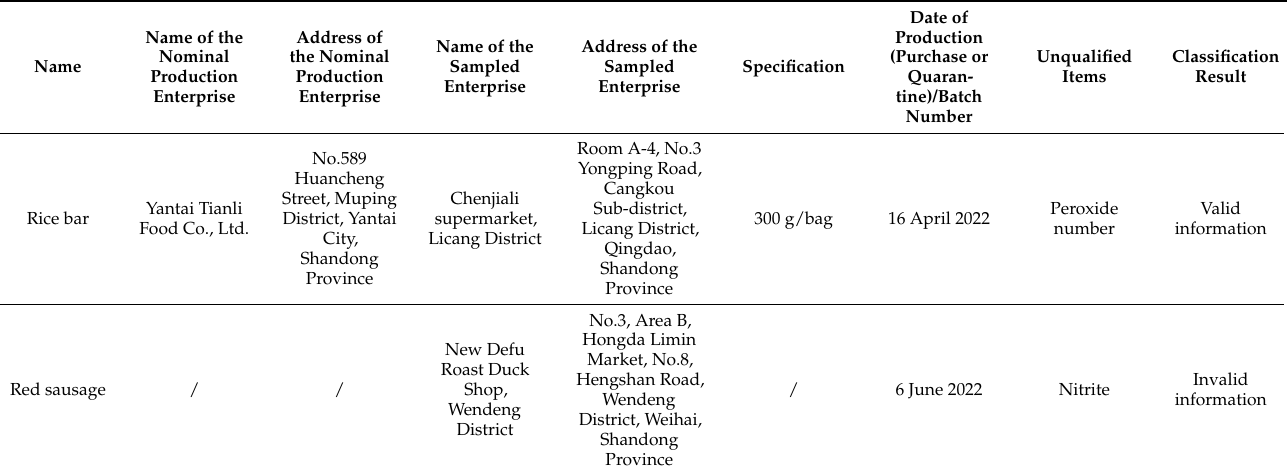
Table 2. Examples of valid and invalid